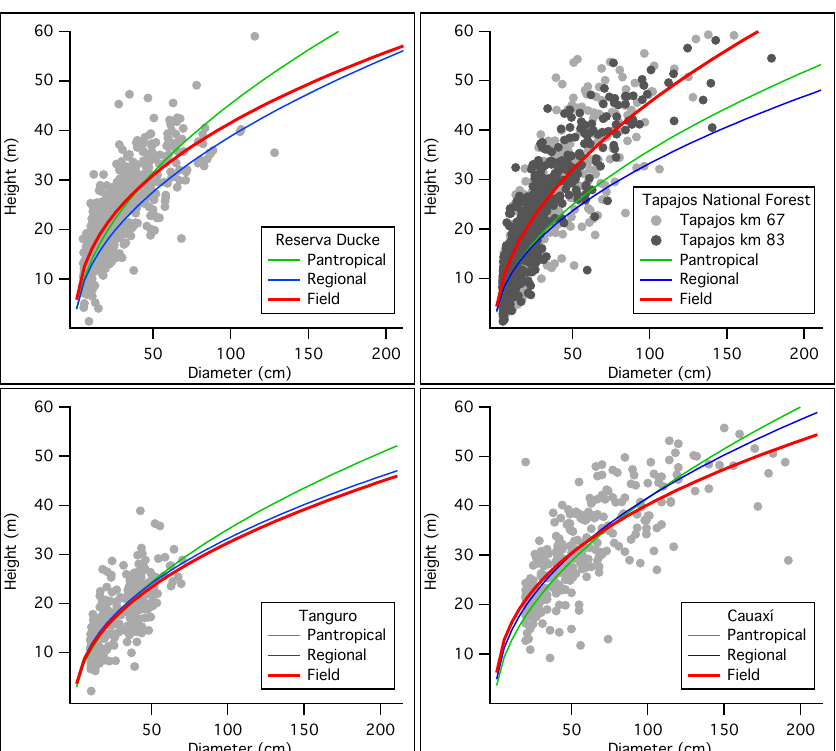
Fig. 4. Comparison of allometric scaling relationships. Regional and pantropical allometries from Feldpausch et al. (2011) that include site- specific climatic and structural parameters (reported in Table 2 and Table 3, respectively) and a site-specific allometry (field) based on height and diameter measurements at all sites: Reserva Ducke, Tapajos, Tanguro and